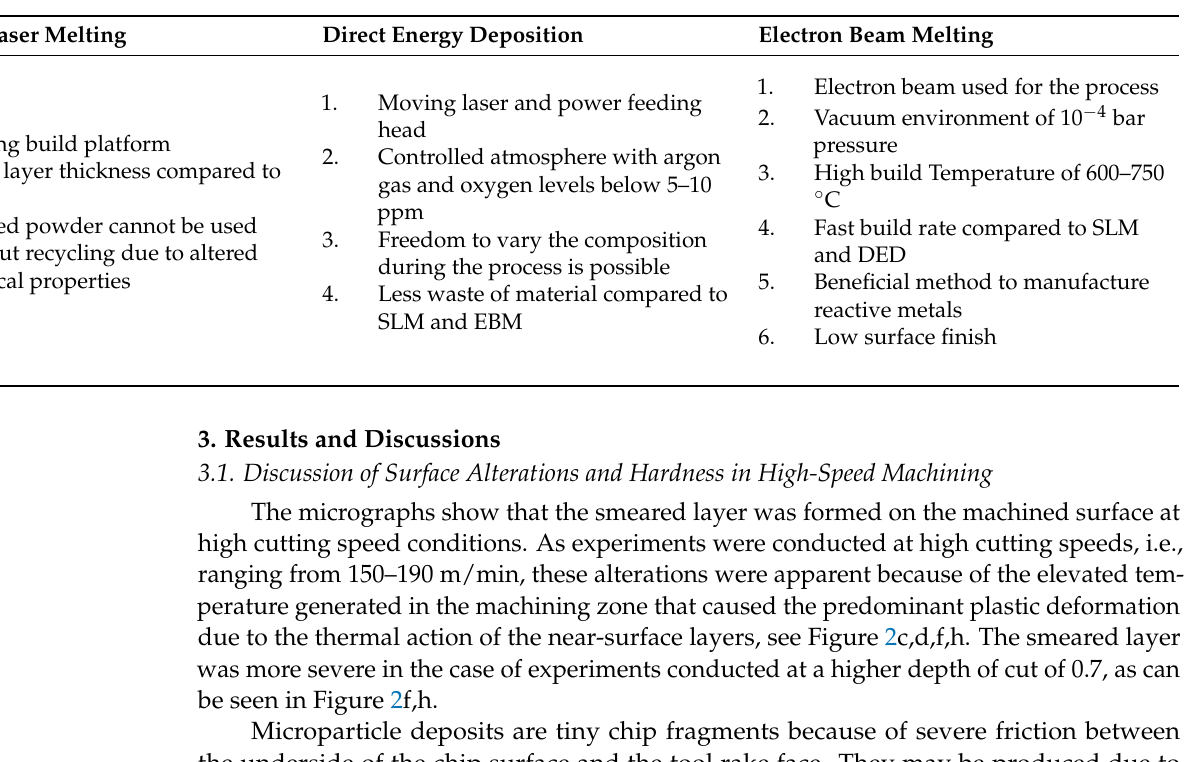
Figure 1. ( a ) CNC lathe used for experimentation; ( b ) geometry of the CNMG 120408 MP inserts; ( c ) Ti6Al4V work pieces; ( d ) Shimatzu microhardness tester; and ( e ) CNMG 120408 MP cutting insert. Popular powder-based methods typically used for Ti6Al4V were selected to create a consistent comparison. The features of various AM processes are listed in Table 1. Table 1. Features of AM processes used to manufacture